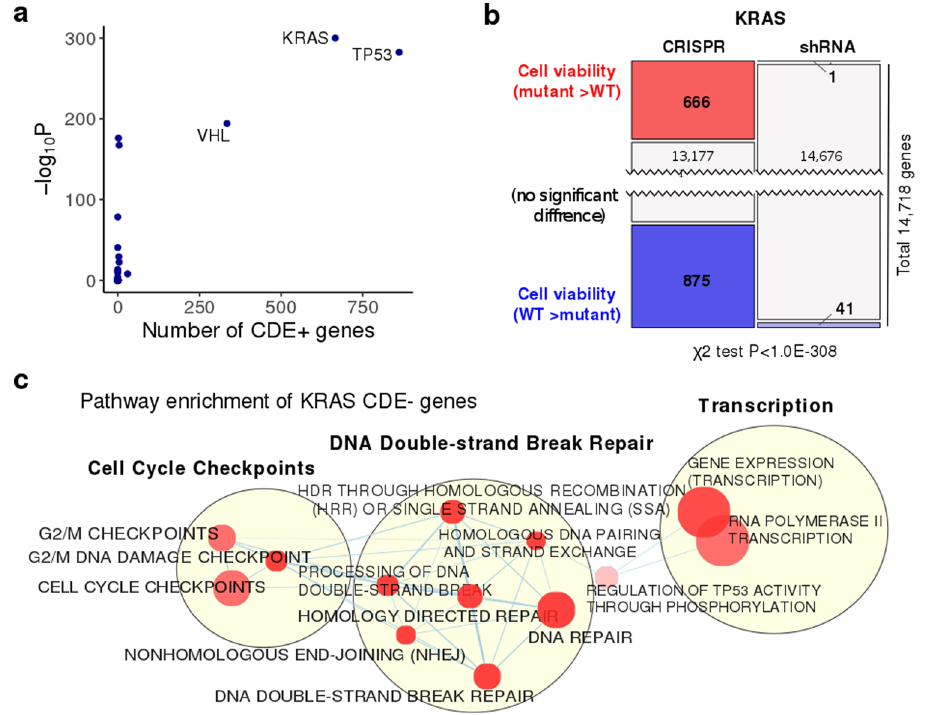
Fig. 5 Large-scale genetic screening identi fi es KRAS as a second major cancer driver whose mutation can be potentially selected for by CRISPR-Cas9. a A scatter plot showing the number of identi fi ed CDE + genes ( x -axis) and the negative log10-transformed P values of one-sided Fisher ’ s exact test ( y - axis) testing for the imbalance in the number of differentially essential genes in CRISPR and shRNA screens for the 61 major cancer driver genes from Vogelstein et al. [27]. p53 and KRAS are identi fi ed as the top two signi fi cant cancer genes with a higher number of CDE + genes. b The number of genes whose essentiality is signi fi cantly associated with KRAS mutational status in CRISPR and shRNA screens ( P = 1.0E – 208, one-sided Wilcoxon rank-sum has been performed with FDR threshold of 0.1). c Visualization of pathways enriched for KRAS CDE-genes where signi fi cance is calculated using the GSEA method as implemented in the R package fgsea21 . Only signi fi cant pathways (FDR > 0.1) speci fi c to CDE and not to the genes showing differential essentiality in the shRNA screens are included. Pathways are shown as nodes whose sizes correlate with pathway lengths and colors represent the signi fi cance of their enrichment (the darker the more signi fi cant). Pathway nodes are connected and clustered based on their functional similarities, and higher-level functional terms are given for each of the clusters (Methods). For clarity, only the largest clusters are